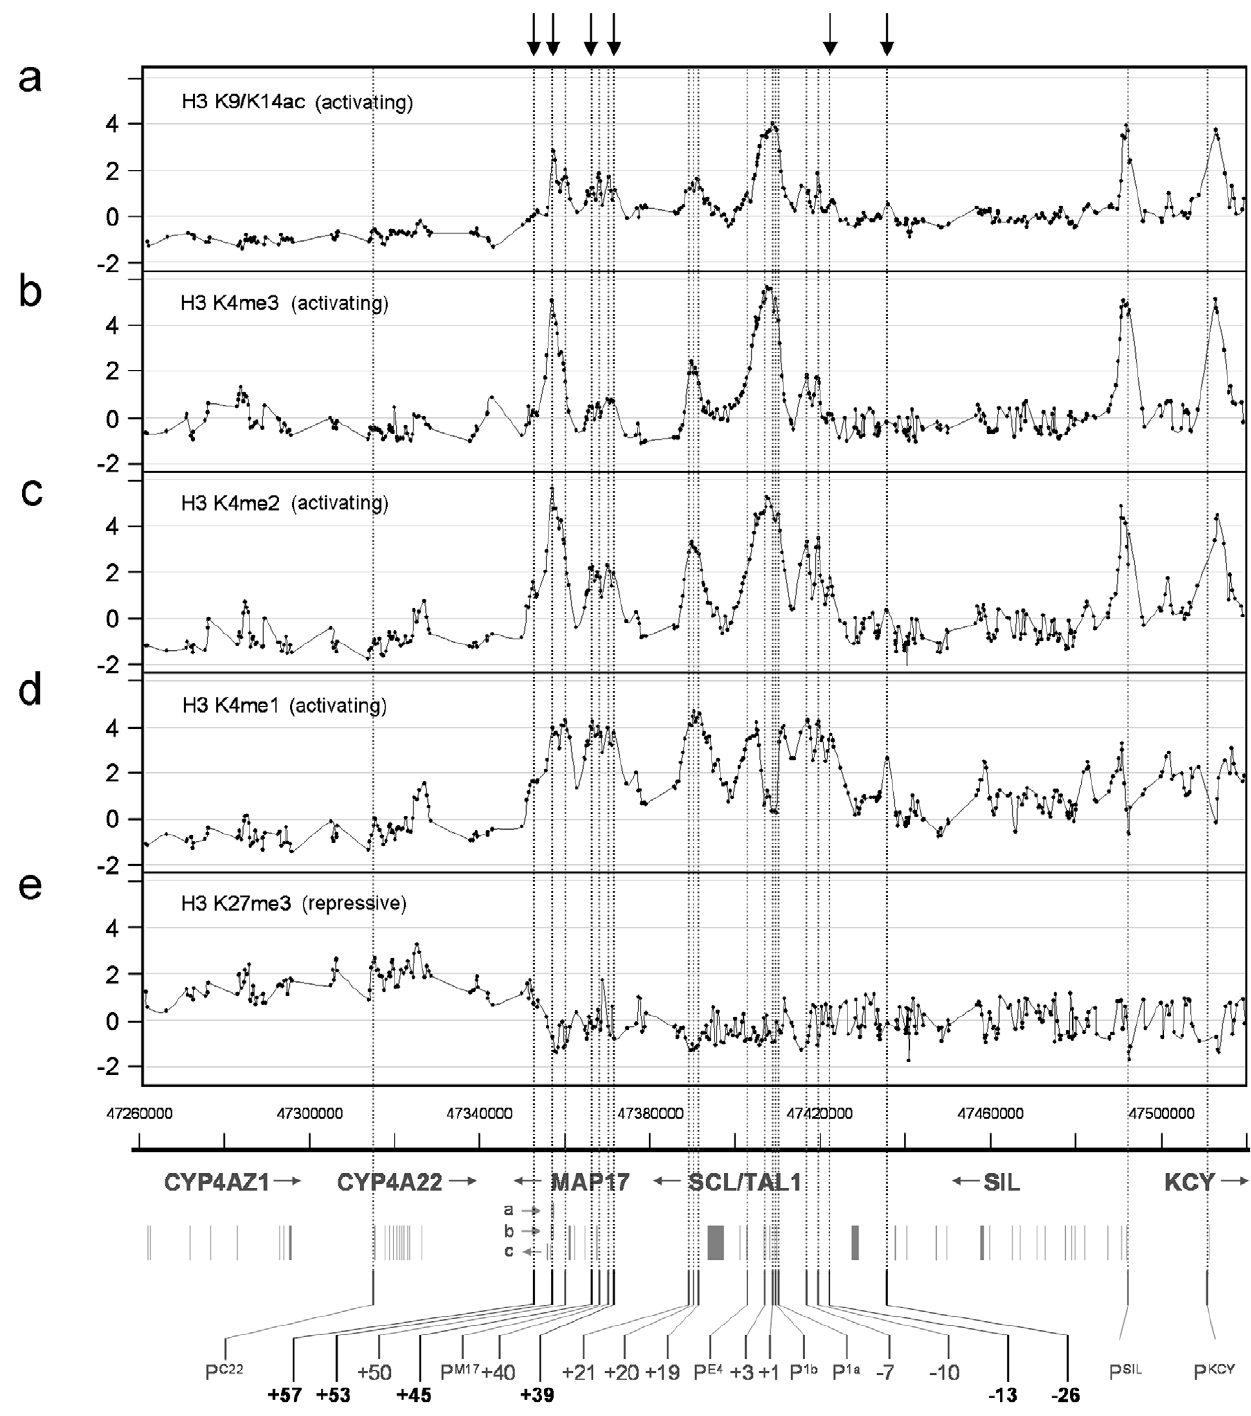
Figure 1. Histone H3 modification profiles across the human SCL locus in the K562 cell line. The modifications studied are named at the left of each panel. Dots on the solid joined-up lines represent the data obtained for each genomic tiling array element. In each panel, the x-axis is the genomic sequence co-ordinate (NCBI build 35) and the y-axis is the enrichment obtained in ChIP-chip assays expressed in log 2 scale. Schematic diagram at the bottom of the figure shows the genomic organisation of SCL and its neighbouring genes. Exons are shown as vertical blocks with gene names and direction of transcription shown above. Transcripts denoted by a,b and c refer to transcripts of unknown function (see also text). Vertical lines at the bottom (with dotted lines through all the panels) show the location of known and novel regulatory regions at the SCL locus. Promoters are denoted by P. Other nomenclature refers to the distance in kb from SCL pro1a (P 1a ). Novel regions are highlighted in bold at the bottom and with arrows at the top of the figure.